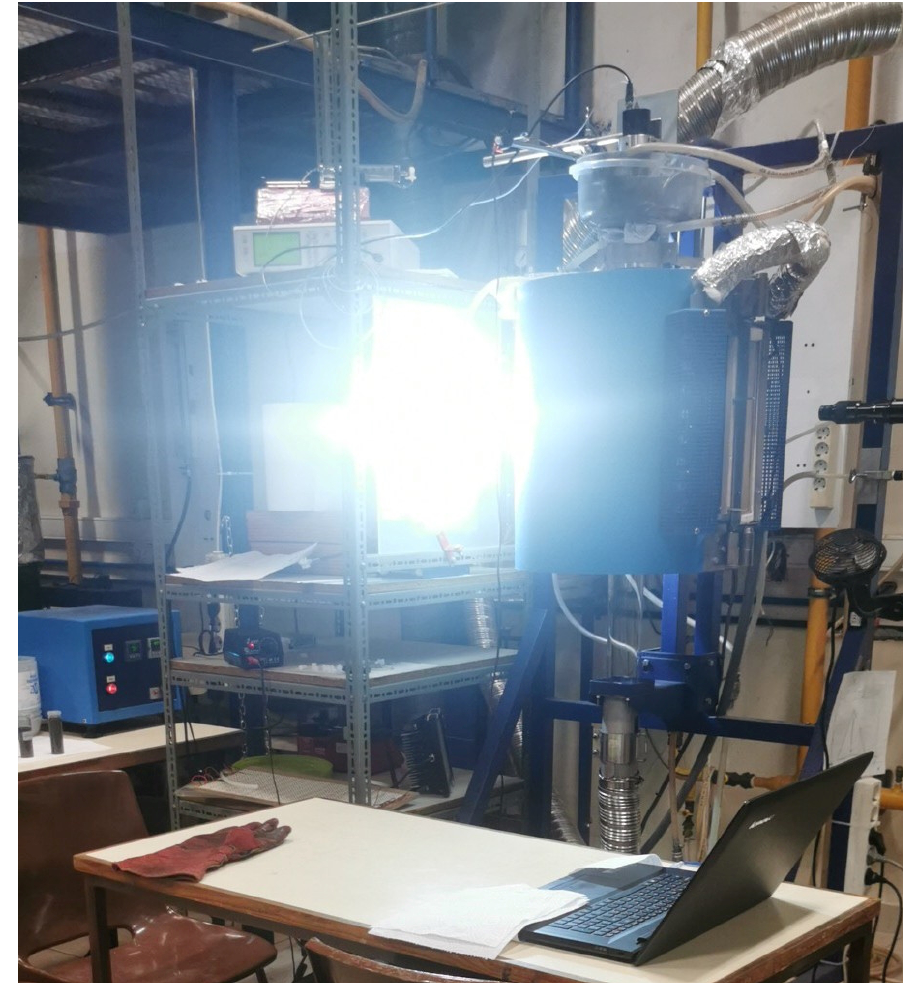
Figure A3. Experimental setup (front